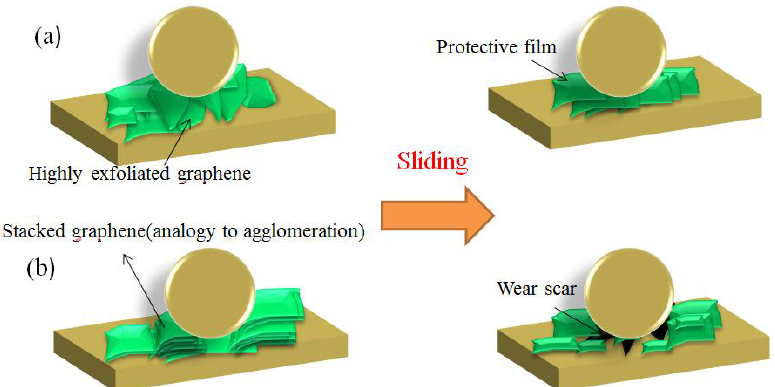
Figure 3. The lubrication mechanisms of graphene in different degrees of peeling. ( a ) During the sliding process, graphene with higher exfoliation restacks to lamellar a protective film. ( b ) The stacked graphene layers are prone to being damaged, and further appear as a wear scar. Reproduced with permission from reference Zhao et al. [73], Copyright 2018, Elsevior.